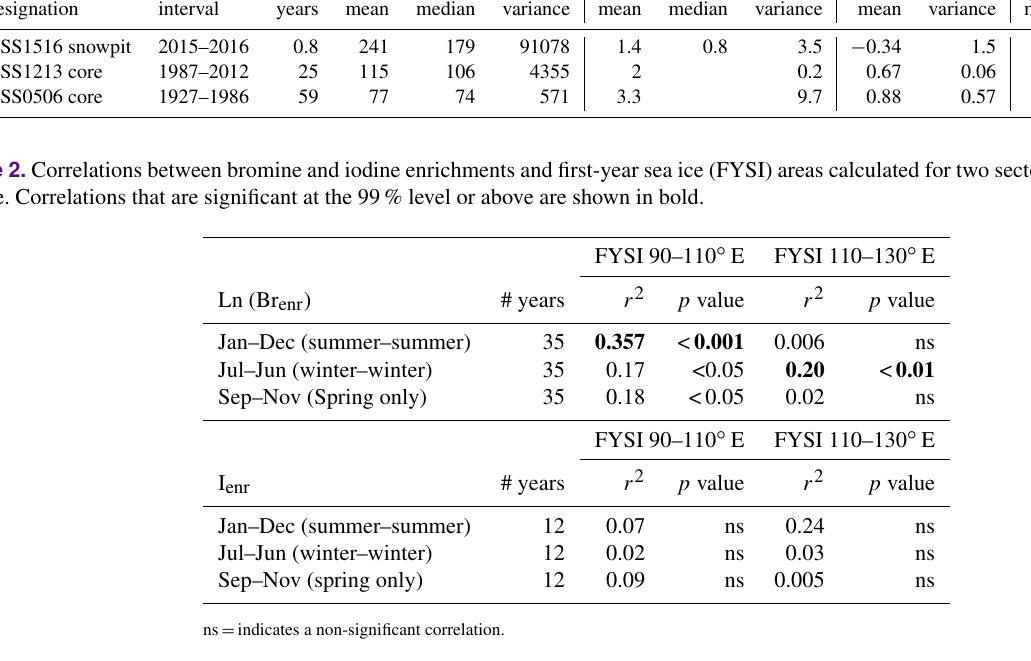
Table 1. Statistical summary of time series data presented from Law Dome Summit South (DSS) ice cores. Sample